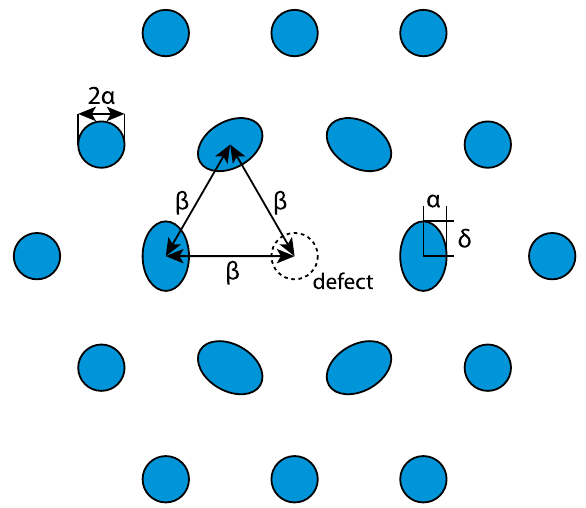
FIG. 2. Elliptical-rod PBG lattice showing lattice spacing (cid:2) , rod radius (minor radius for elliptical rods) (cid:1) , and major radius (cid:3) .